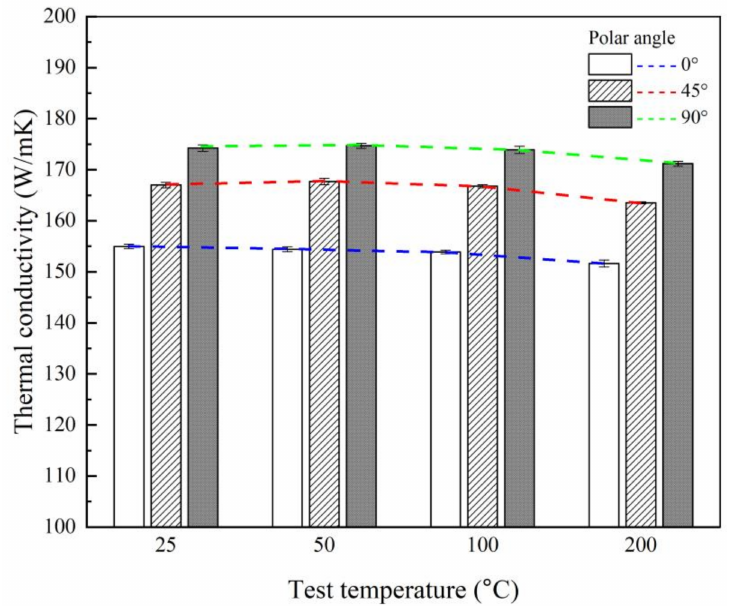
Figure 6. Comparison of thermal conductivity for case 2 as a function of the polar angle at test temperatures of 25, 50, 100, and 200 ◦ C.